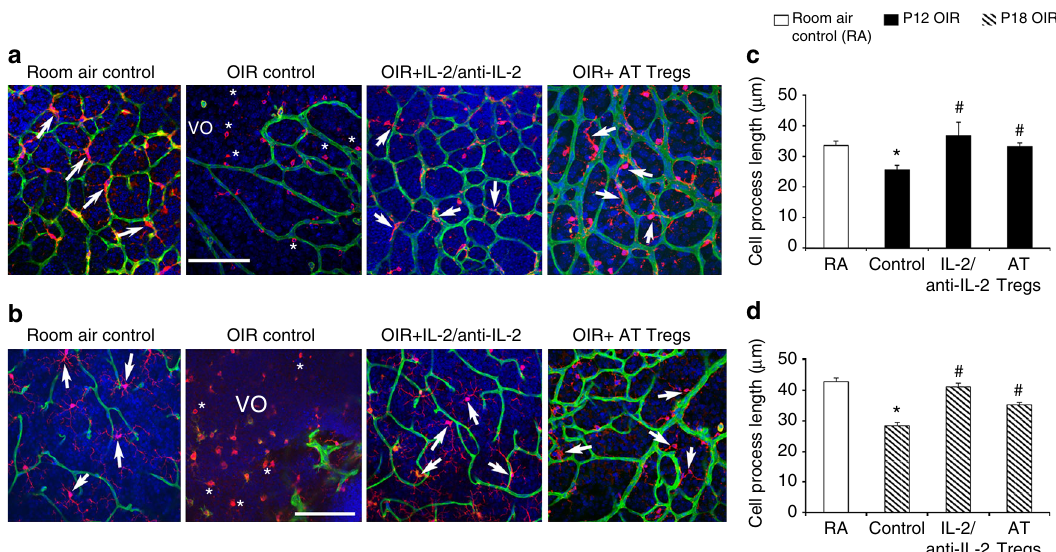
Fig. 6 Expanding Treg numbers preserved the rami fi ed phenotype of microglia. Representative confocal images of fl at mounted retina from C57BL/6J mice showing blood vessels (isolectin, green ), microglia (Iba1 + , red ), and nuclei (DAPI, blue ). Scale bar , 100 μ m. In room air controls (RA) at a P12 and b P18, Iba1 + cells with long rami fi ed processes ( arrows ) predominate, while in OIR at both time points, most Iba1 + cells exhibit short cell processes ( asterisks ) and are found in the vaso-obliterated ( VO ) retina. In OIR mice treated with the IL-2/anti-IL-2 mAb complex or the adoptive transfer (AT) of Tregs, the number of Iba1 + cells with long rami fi ed cell processes ( arrows ) predominate. The primary cell process of each Iba1 + cell per fi eld of retina was quantitated at c P12 and d P18. * P < 0.05 to RA. # P < 0.05 to OIR control (one-way ANOVA with Mann – Whitney U test). n = 6 room air control mice and 8 mice/OIR group. Values are expressed as mean ±